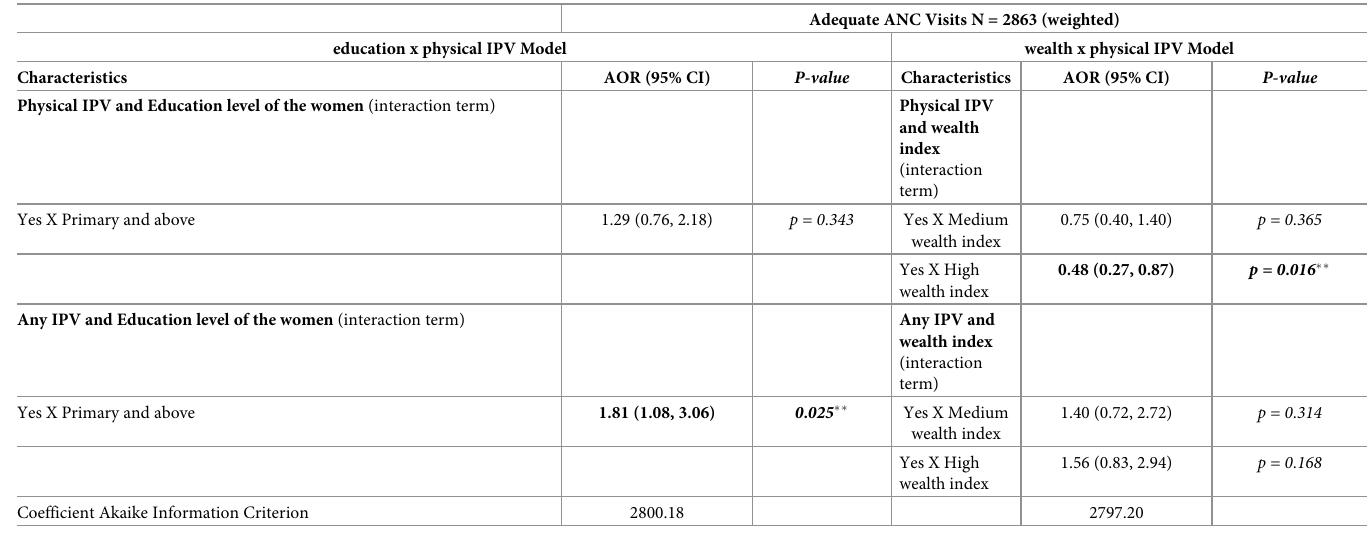
Table 3. Association between ever exposure to physical/any forms of IPV, and utilization of antenatal care and the moderating effect of education and wealth.